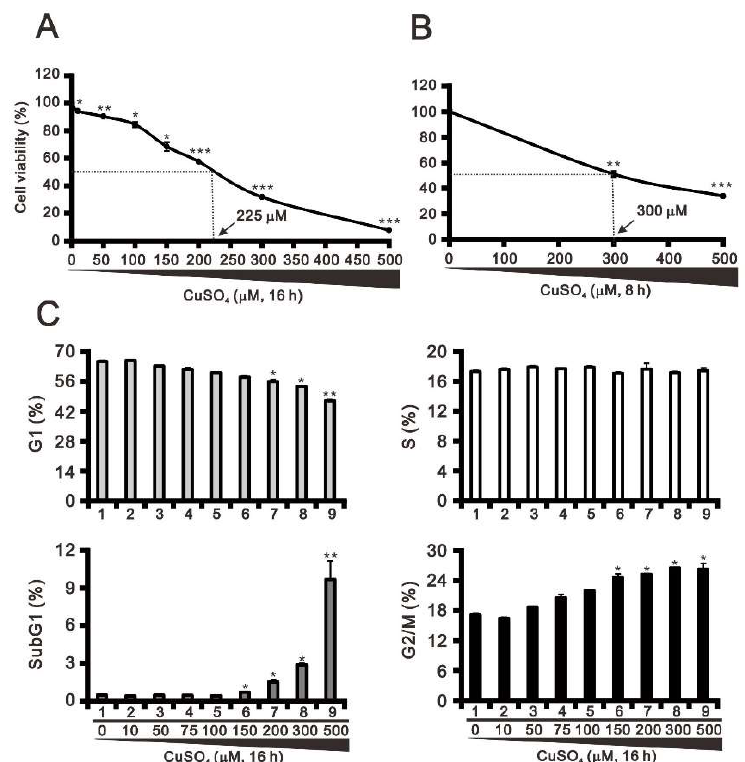
Figure 1. E ff ects of copper sulfate on cell viability and the cell cycle profile. ( A , B ) HeLa cells were treated with the indicated concentrations of copper sulfate for 16 h ( A ) or 8 h ( B ). Cell viability was measured using the MTT method. ( C ) HeLa cells were incubated with the indicated concentrations of copper sulfate for 16 h and then subjected to flow cytometric cell cycle profile analysis. The results are representative of three independent experiments. * p < 0.05, ** p < 0.01, and *** p < 0.001.